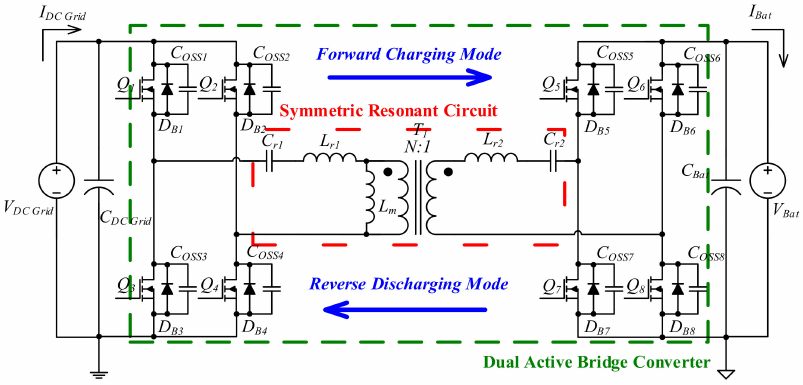
Figure 1. The proposed isolated bidirectional symmetric resonant converter with dual active full